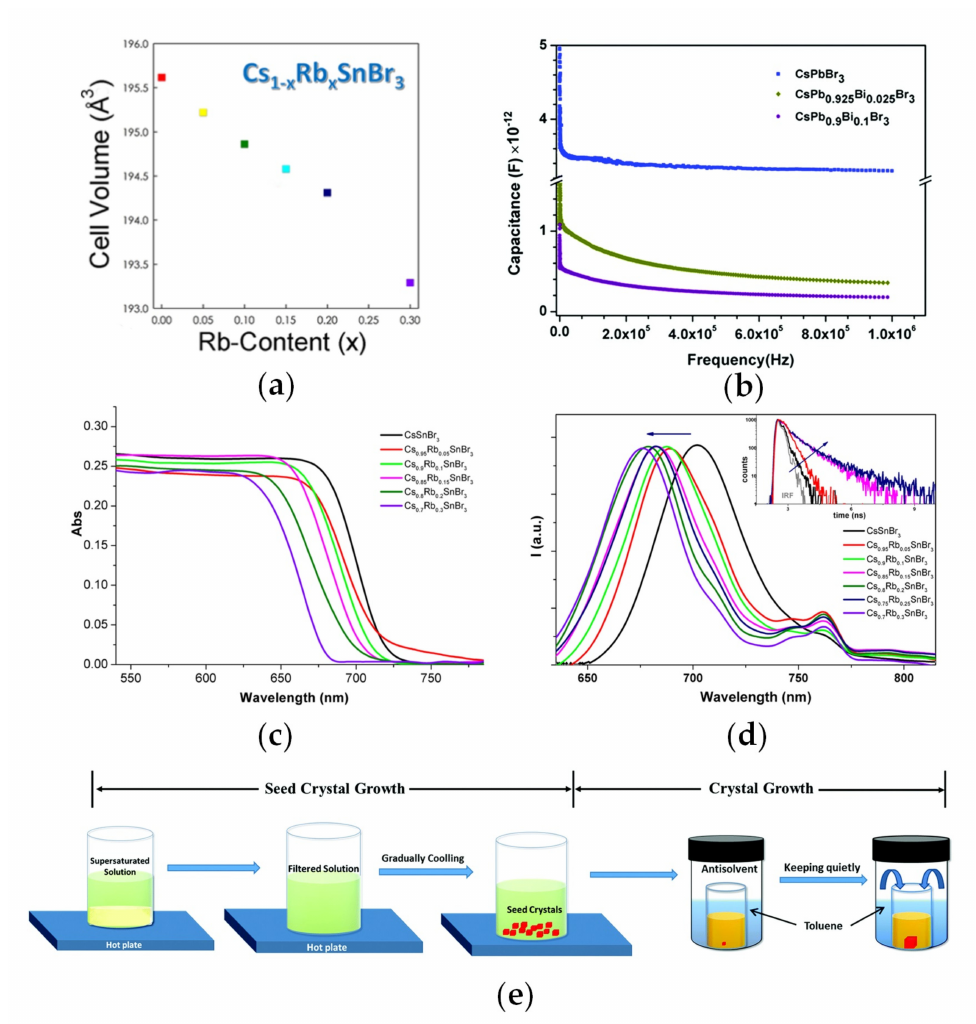
Figure 7. ( a ) With the doping of atoms, the size and structure of crystal cells change. Adapted with permission from Ref. [113]. 2019, American Chemical Society; ( b ) capacitance test results of CsPbBr 3 and CsPb x Bi 1 − x Br 3 single crystals at different frequencies. Adapted with permission from Ref. [112]. 2017, Royal Society of Chemistry; total absorption spectra ( c ) and PL spectra ( d ) of Cs 1 − x Rb x SnBr 3 samples with 0 ≤ x ≤ 0.3. Adapted with permission from Ref. [113]. 2019, American Chemical Society; ( e ) schematic diagram of the modified AVC method. Adapted with permission from Ref. [112]. 2017, Royal Society of